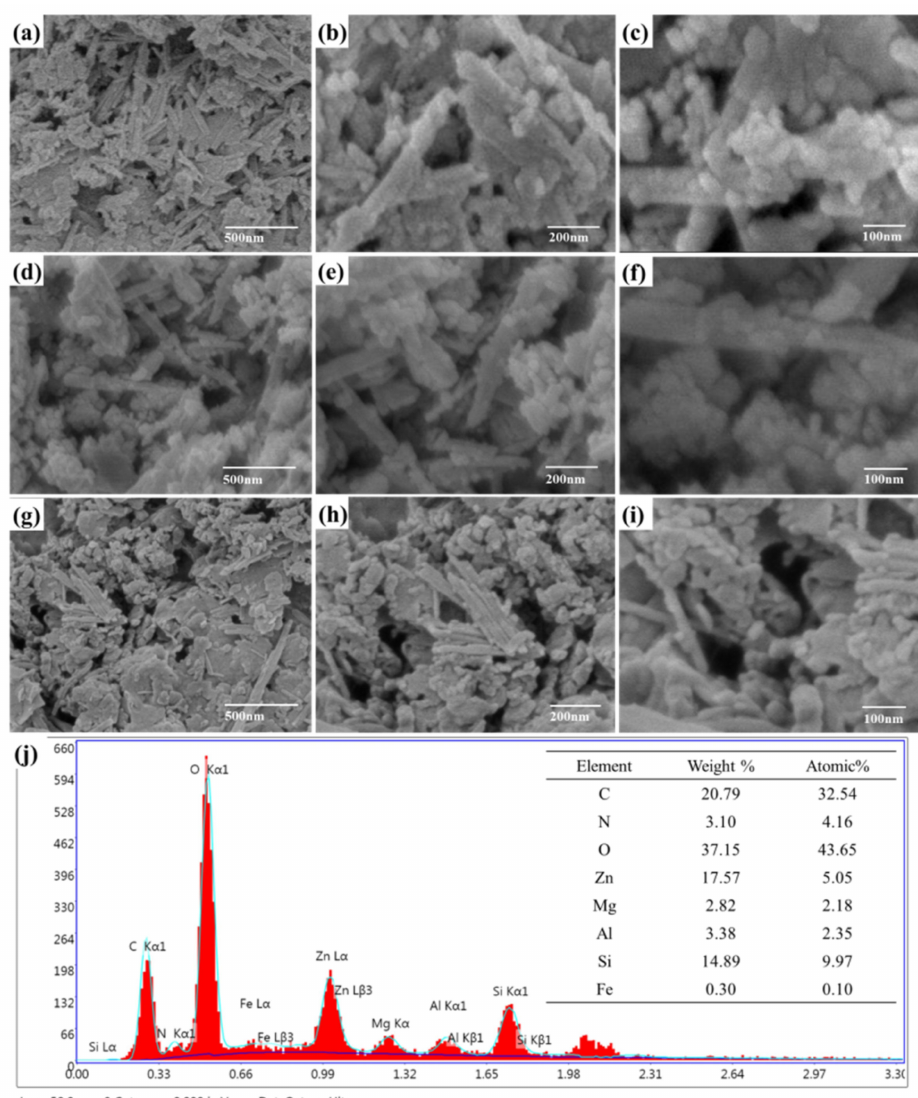
Figure 1. FESEM images of ( a – c ) ZnO/APT, ( d – f ) C–ZnO/APT and ( g – i ) MAG/C–ZnO/APT-2.5%, and ( j ) EDX spectrum of